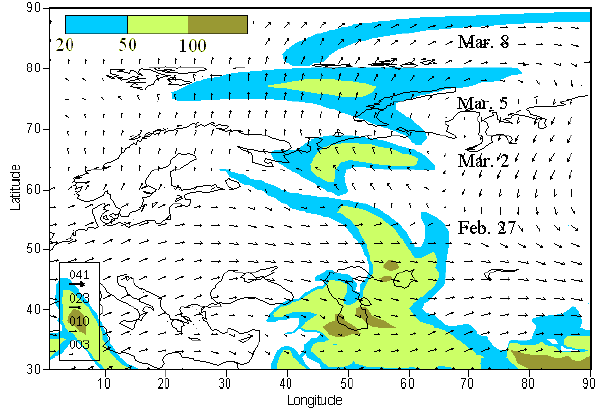
Fig. 7. Same as Fig. 2 but for 1–8 March 1999 and the region of